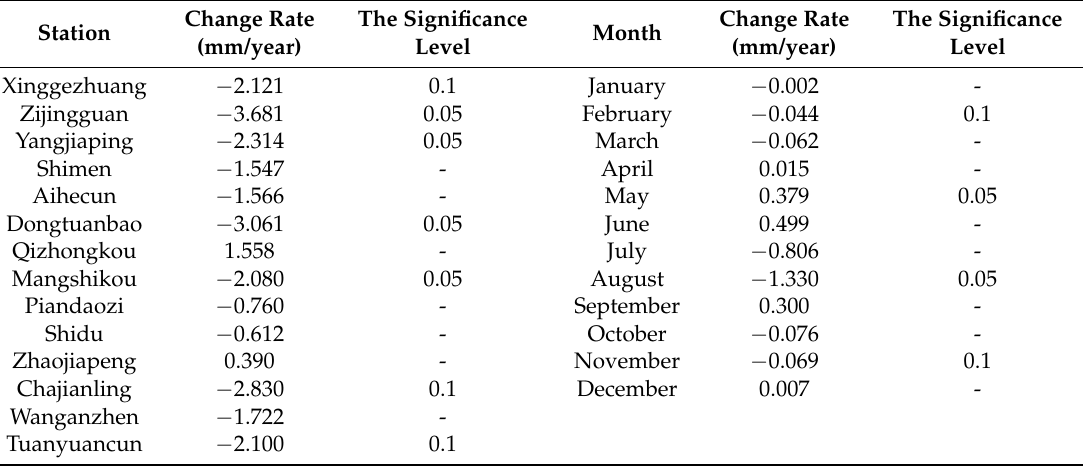
Table A2. The MK results of precipitation time